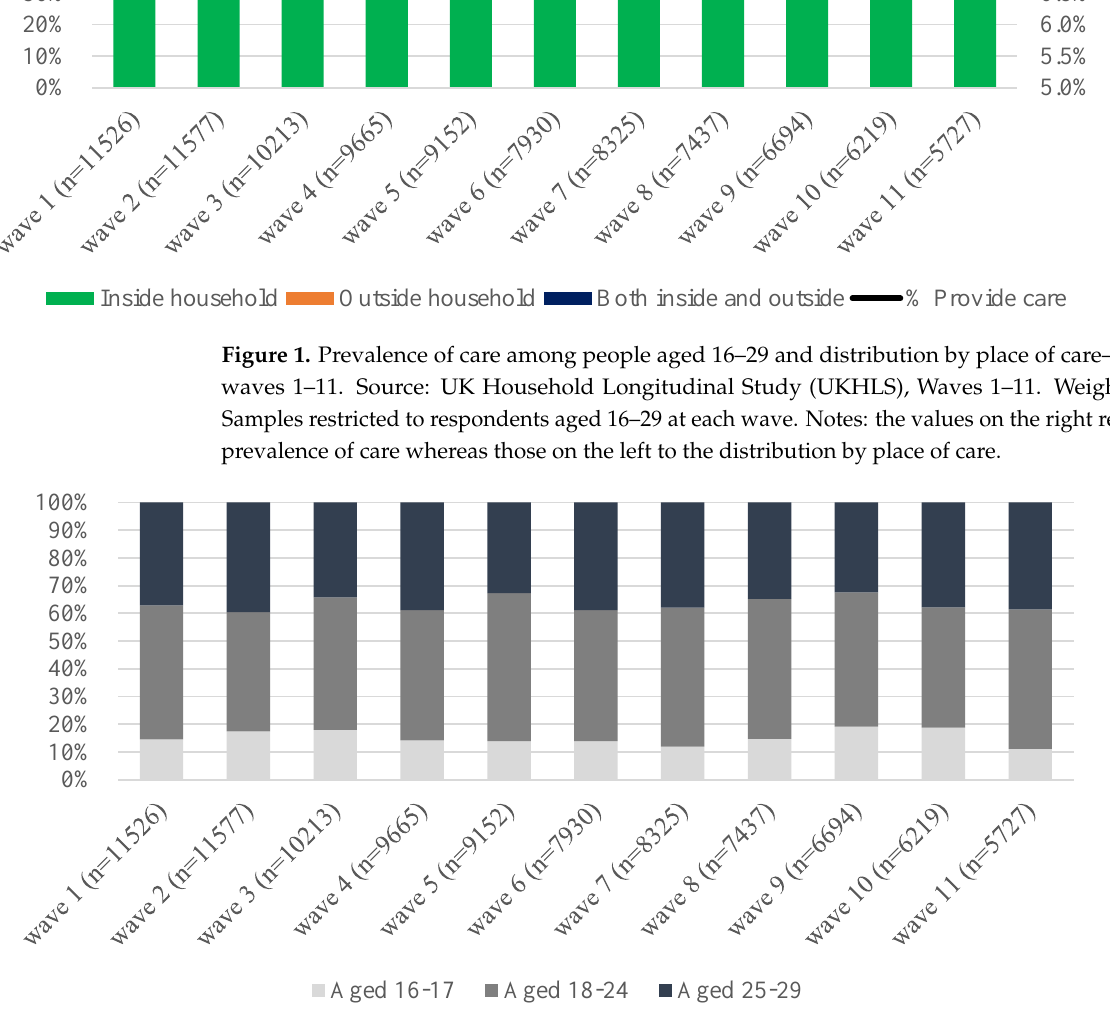
Figure 2. Distribution of care among people aged 16–29 by age groups—UKHLS waves 1–11. Source: UKHLS, Waves 1–11. Weighted data. Samples restricted to respondents aged 16–29 at each wave.